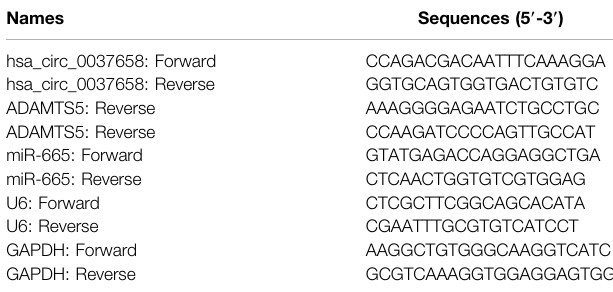
TABLE 1 | Sequences of primers for RT-qPCR used in this